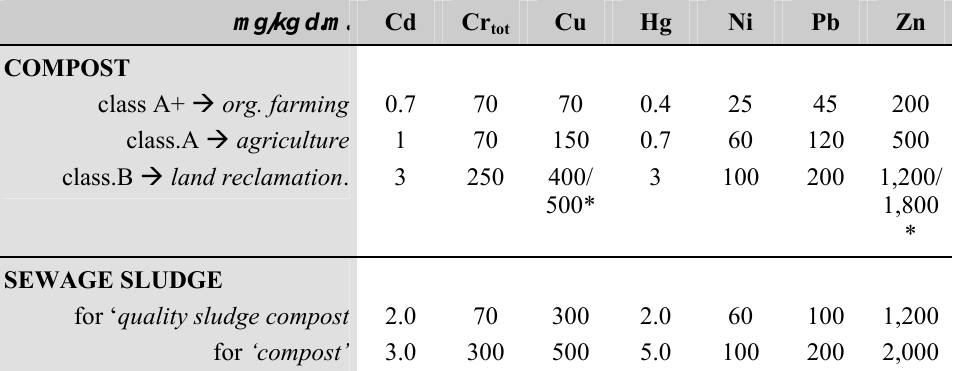
Maximum heavy metals concentration for composts and sewage sludge as input material according to the Austrian Compost Ordinance mg/kg d.m. Cd Cr Cu Hg Ni Zn tot COMPOST class A+ (cid:198) org. farming class.A (cid:198) agriculture class.B (cid:198) land reclamation .